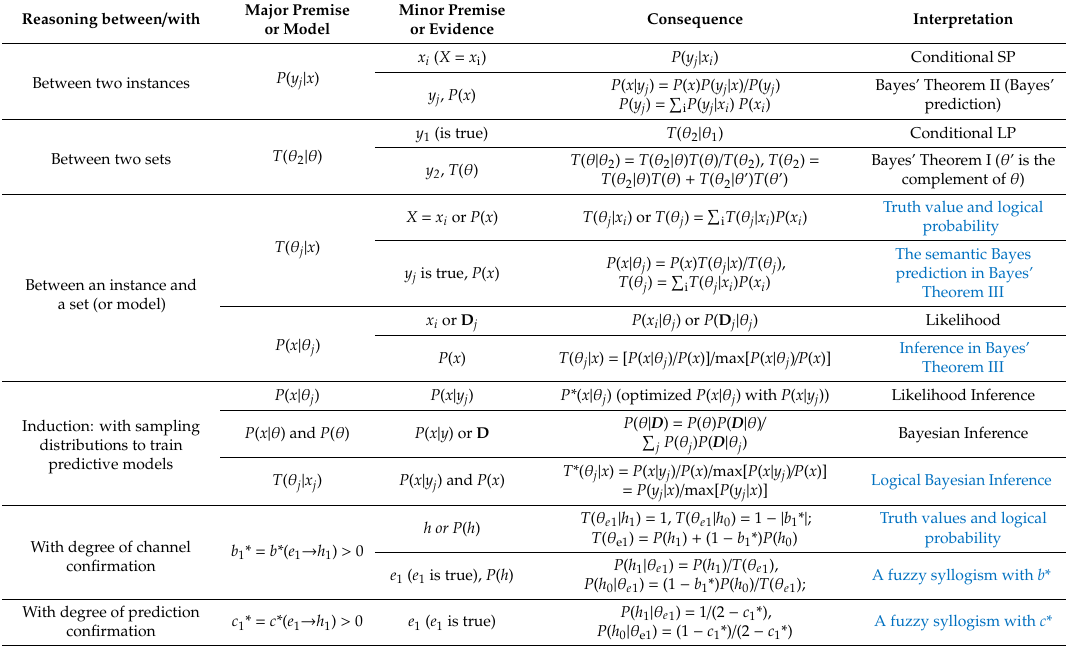
Table 4. The di ff erent forms of Bayesian